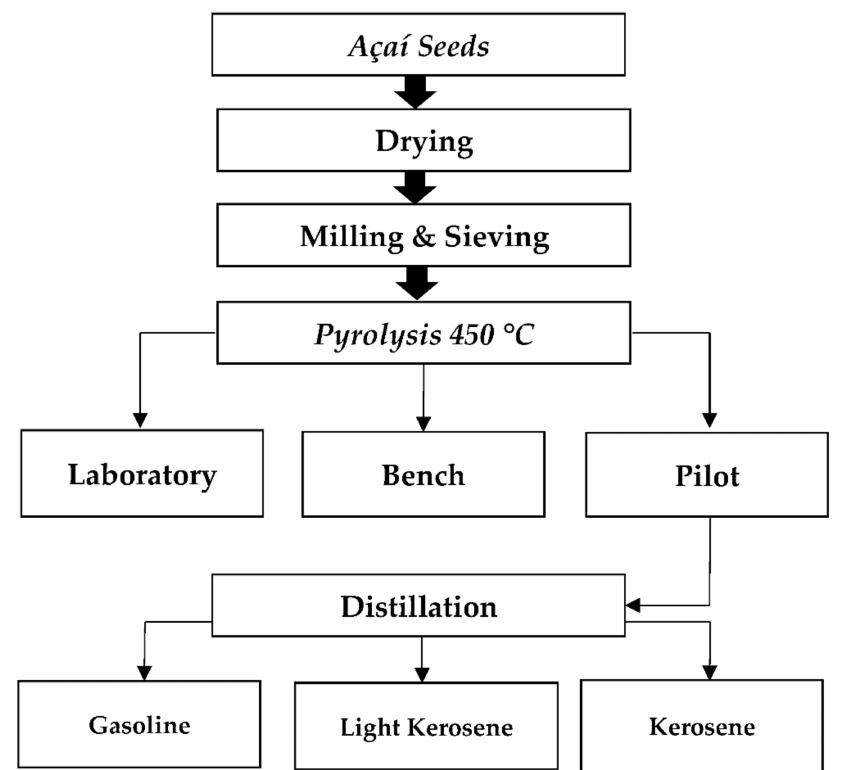
Figure 1. Process flow sheet by the production of fuel-like fractions (gasoline, light kerosene, and kerosene) obtained by fractional distillation of bio-oil obtained in laboratory, bench, and pilot